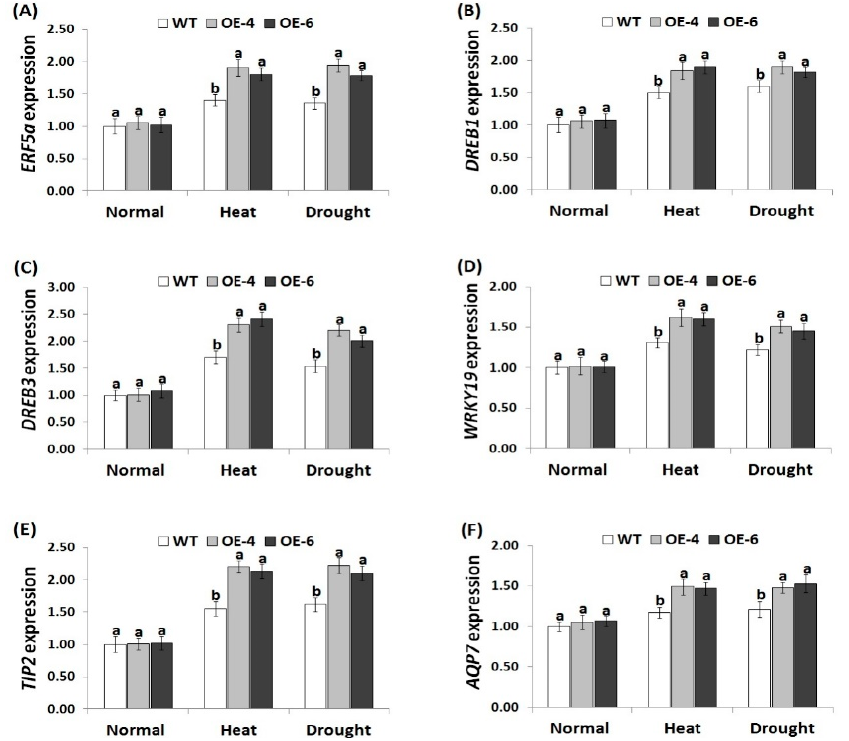
Figure 7. Expression levels of ERF5a ( A ), DREB1 ( B ), DREB3 ( C ), WRKY19 ( D ), TIP2 ( E ), and AQP7 ( F ) genes in wild type and transgenic plants under normal and stress treatments. Data indicate means ± SE ( n = 4). Different letters on columns denote significant difference ( p ≤ 0.05).